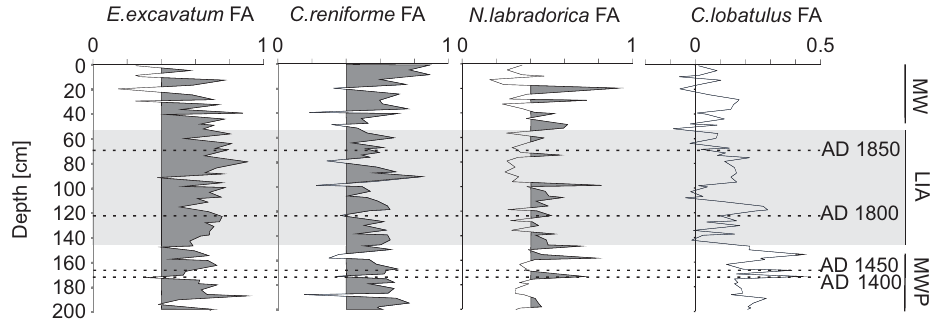
Figure 5. PC loading values for four foraminiferal assemblages found in the HF_2011 core. The statistically significant loadings are marked in grey. MWP: Medieval Warm Period; LIA: Little Ice Age; MW: modern warming. The time ranges of the MWP, LIA and MW are presented after Majewski et al.